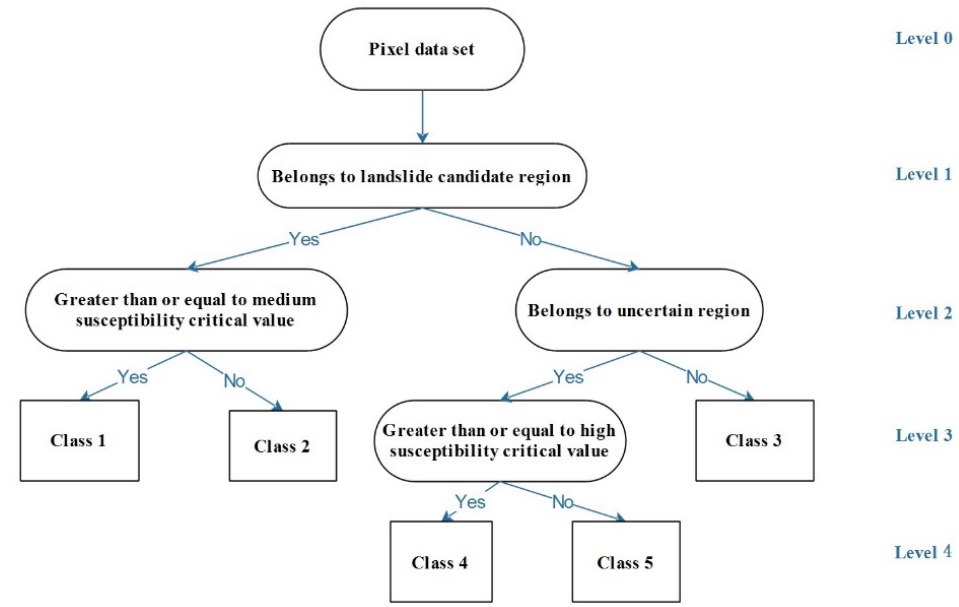
Figure 6. Conditions to divide pixels.